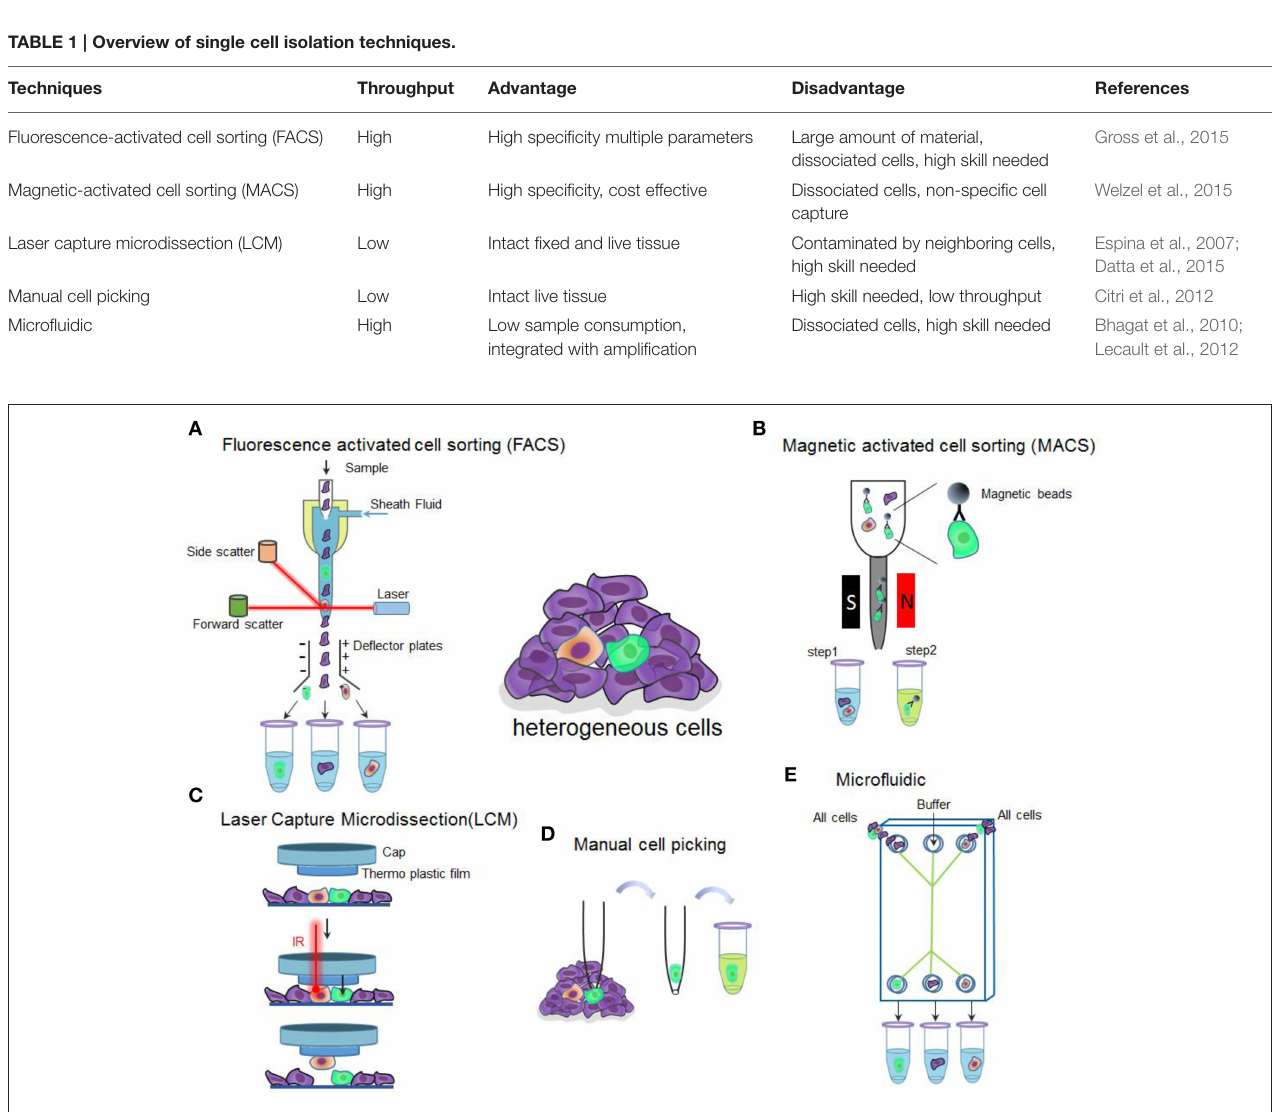
FIGURE 1 | Overview of single-cell isolation technologies discussed in the section. (A) Schematic of fluorescence-activated cell sorting. The suspended labeled cells are passed as a stream in droplets with each containing a single cell in front of a laser. The fluorescence detection system detects the fluorescent and light scatter characteristics. Based on their characteristics, the instrument applies a charge to the droplet containing a cell of interest and an electrostatic deflection system facilitates collection of the charged droplets into different collecting tubes. Cells labeled with green, purple, and yellow indicate different cell types. (B) Schematic of magnetic-activated cell sorting. Cells of interest are labeled with specific antibody conjugated magnetic beads. An external magnetic field is used to separate the labeled cells from the cell suspension. S and N indicate magnetic field. (C) Schematic of laser capture microdissection. The technique utilizes a laser which fired through the cap over the cells of interest to melt the membrane to let the cells adhere to the melted membrane. When the cap is removed, captured cells are removed, leaving the unwanted cells behind. (D) Schematic of manual cell picking. The cells of interest are monitored under a microscope. By using a glass pipette